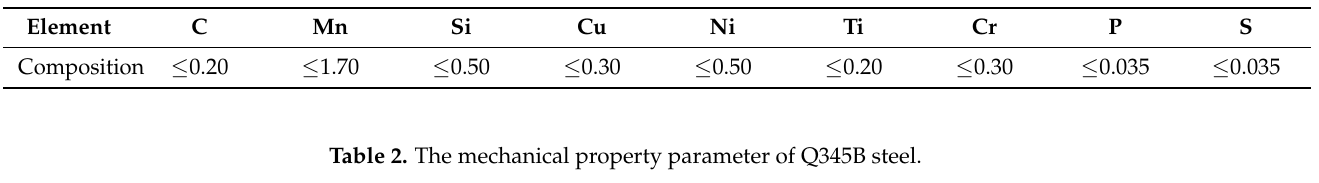
Table 1. Main chemical element composition of Q345B steel (mass fraction, wt.%).